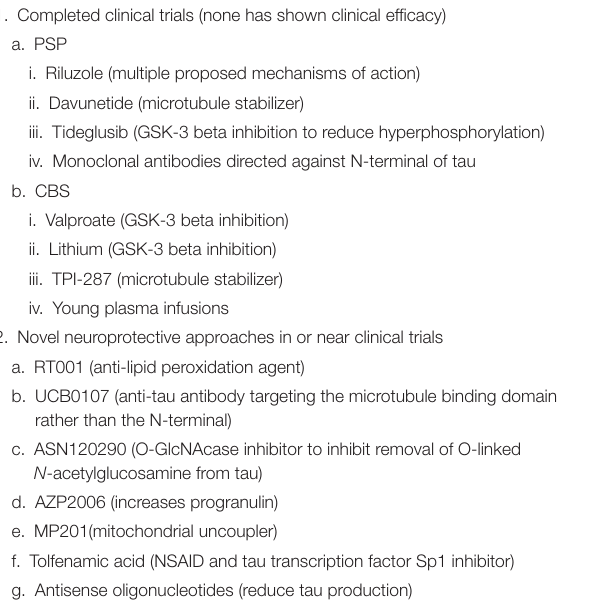
TABLE 13 | Experimental neuroprotective approaches and clinical trials for